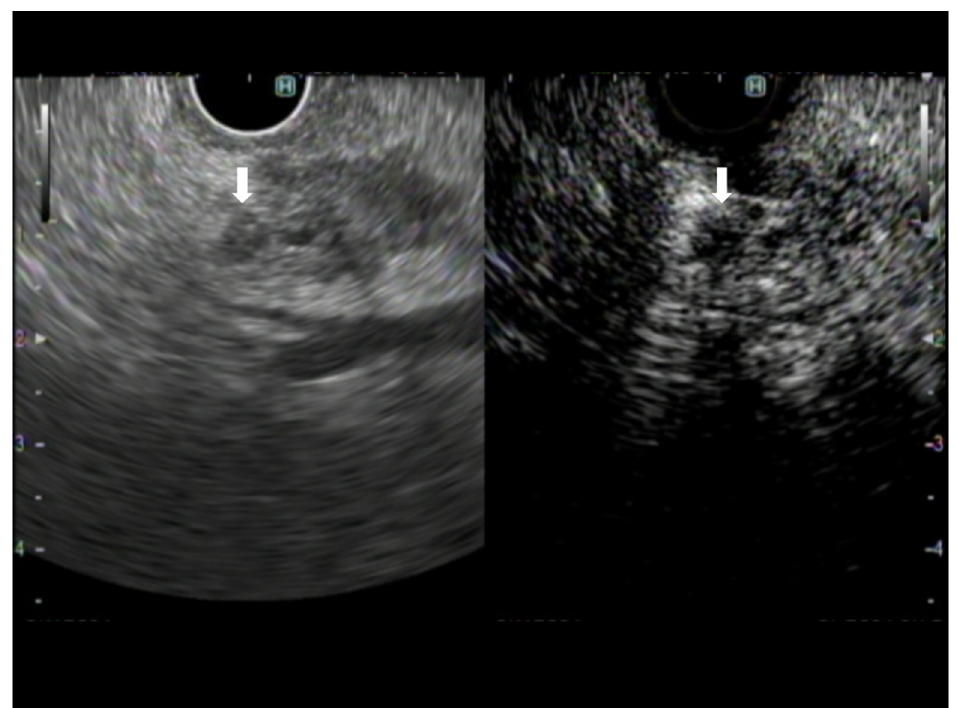
Figure 1. A case of pancreatic adenocarcinoma. The image on the left shows B-mode EUS, and the image on the right shows CH-EUS. The avascular area observed in the CH-EUS image is recognized on B-mode EUS as a hypoechoic area compared with the surrounding lesion within the tumor (arrow).